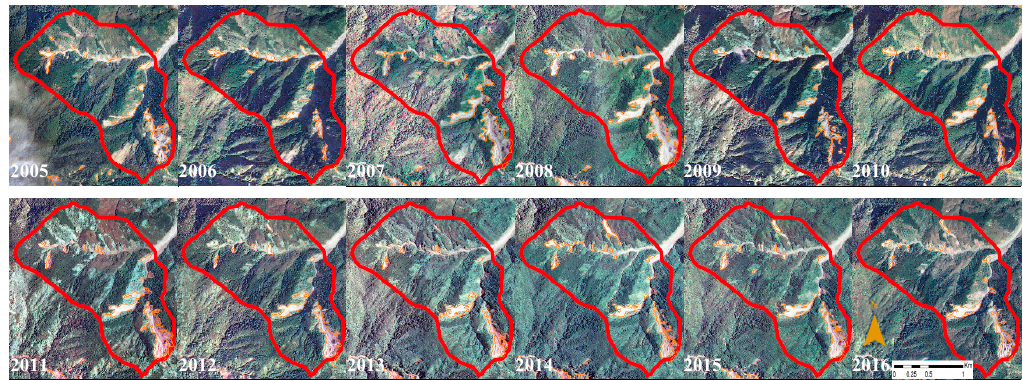
Figure 12. The annual thumbnail images overlaid with the corresponding landslide polygons in optimum sub-watersheds No. 22253, which is categorized as a large-scale landslide area with a level of instability of 5.